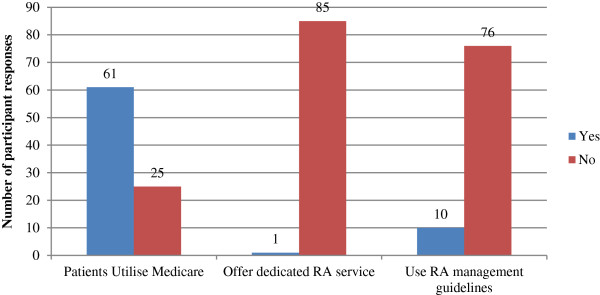
Bar chart indicating what foot care provision was available for people with RA.